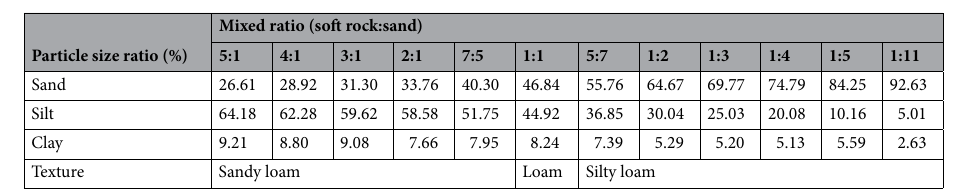
Table 2. Mechanical composition of different proportions of compound soil.